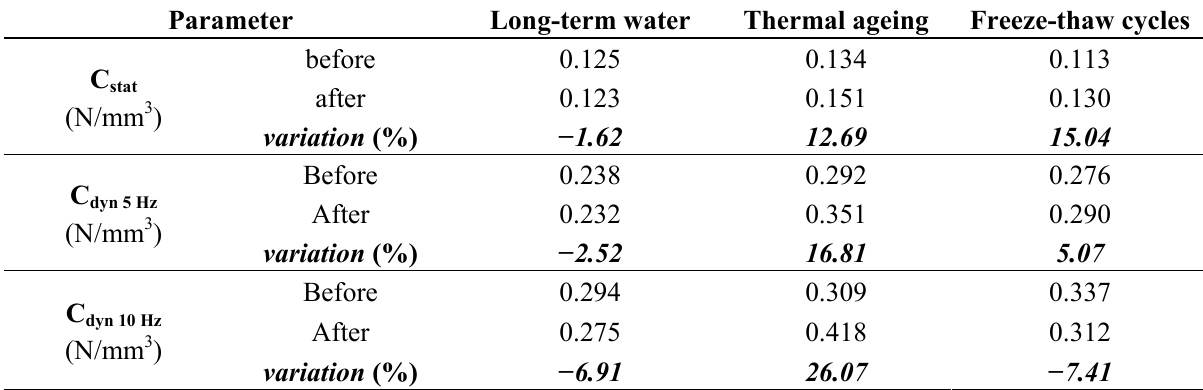
Table 6. Results of tire mats resistance to climatic deterioration. Bold italics show the variation between the properties before and after applying climatic